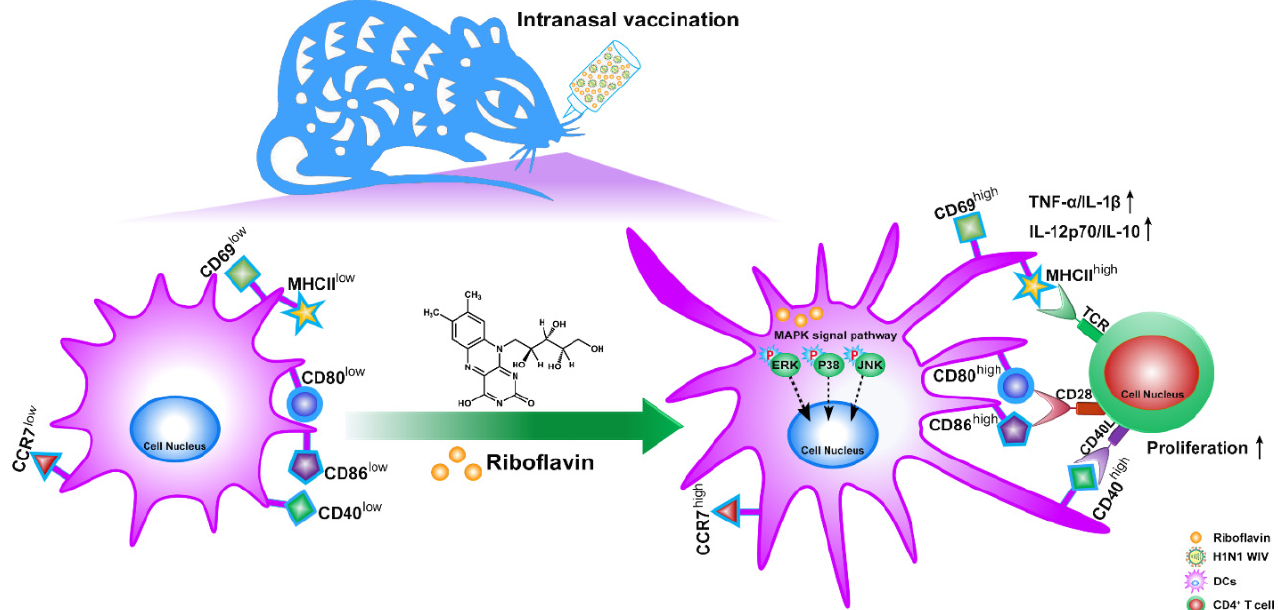
Figure 9. Schematic of the proposed mechanism by which riboflavin improves the immune response. Riboflavin first activated the MAPK signaling pathway, and then induced DC maturation, including through an activation marker (CD69), cytokine secretion (TNF- α , IL-1 β , IL-12p70, and IL-10), phenotypic markers (MHCII, CD40, CD80, and CD86), a migration marker (CCR7), and the proliferation of allogeneic T cells. Furthermore, riboflavin enabled inactivated influenza nasal vaccine to trigger the downstream mucosal and systemic immune responses.